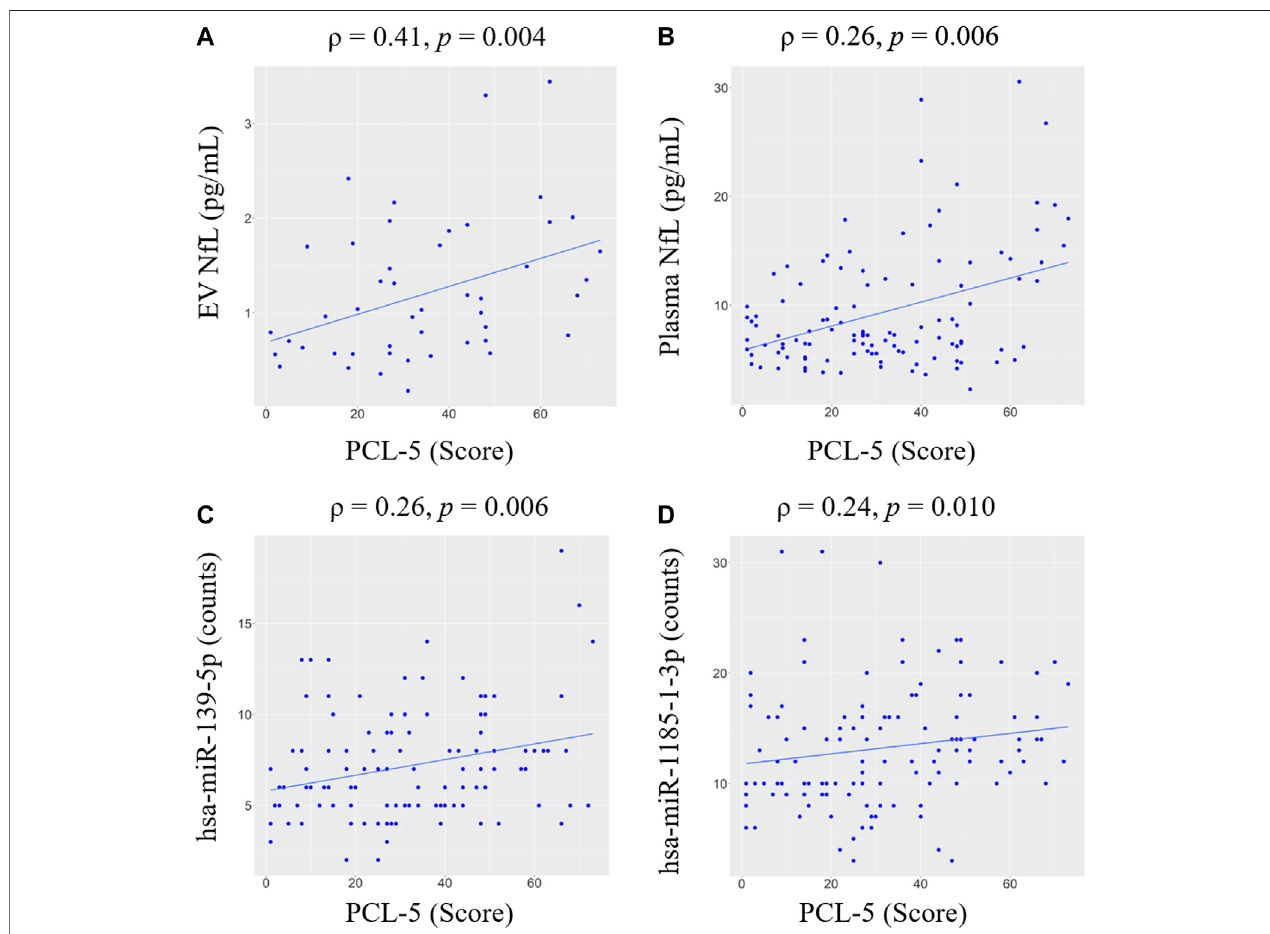
FIGURE 1 | Correlations between PCL-5 scores and biomarker levels within the TBI group. Spearman correlation coef fi cients ( ρ ) and signi fi cance levels ( p ) are shown for (A) EV NfL, (B) plasma NfL, (C) hsa-miR-139 – 5p, (D) hsa-miR-1185-1-3p. Only signi fi cant correlations are shown. Regression line is shown in blue. Abbreviations: neuro fi lament light chain (NfL); PTSD Checklist for DSM-5 (PCL-5); extracellular vesicle